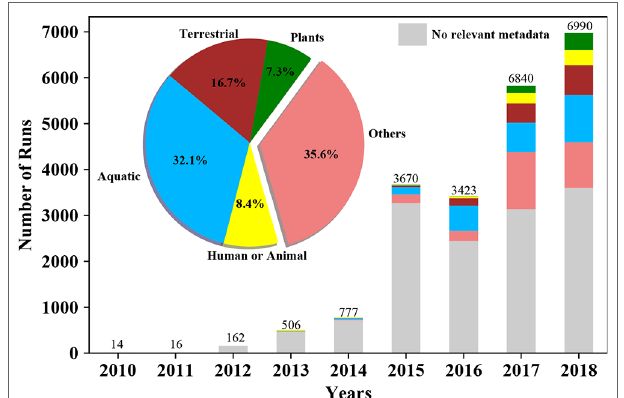
FIGURE 1 | Growth of metatranscriptomics projects in public repositories, together with associated metadata, over time. Bars plots represent number of metatranscriptomic datasets (i.e. ”runs”) deposited in the NCBI Sequence Read Archive (SRA) on a per annual basis. The pie chart and the stacked bars are colored based on the source/environment (isolation_source) the sample has been isolated from. The lowest bar in grey represents the number of samples in SRA without this pertinent